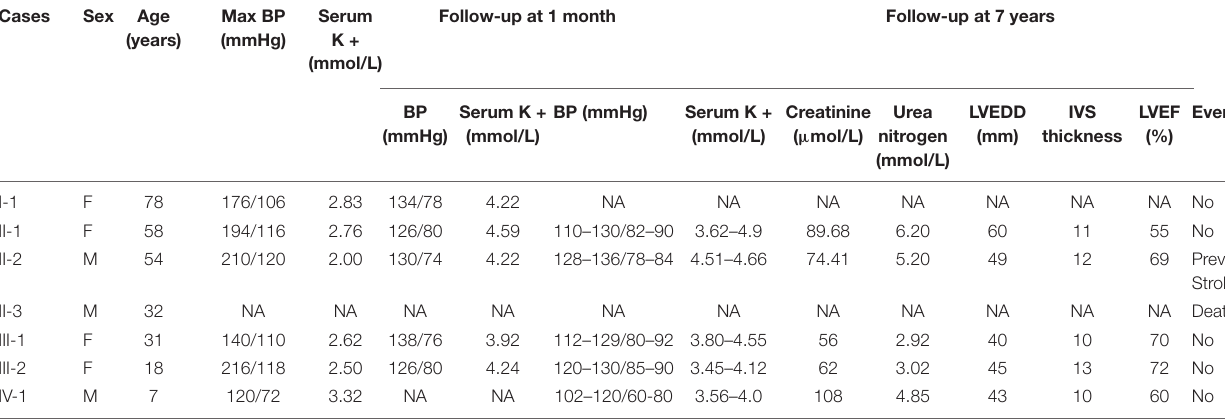
TABLE 1 | Clinical, biochemical characteristics and results of follow-up of patients in this family. Cases